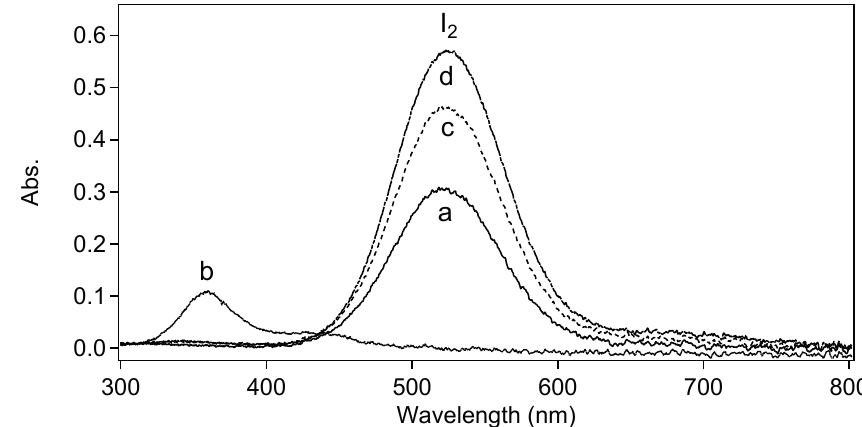
Figure 1. UV-visible absorption spectra of sonicated suspensions of HI 3 O 8 powder in various solvents: ( a ) ethanol; ( b ) ethanol:2-butanone; ( c ) ethanol:ethyl acetate; and ( d ) denatured ethanol. All aliquots were diluted with